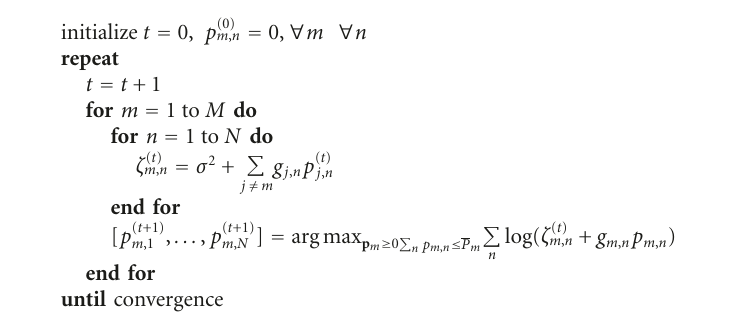
Algorithm 1: DPIWF algorithm.